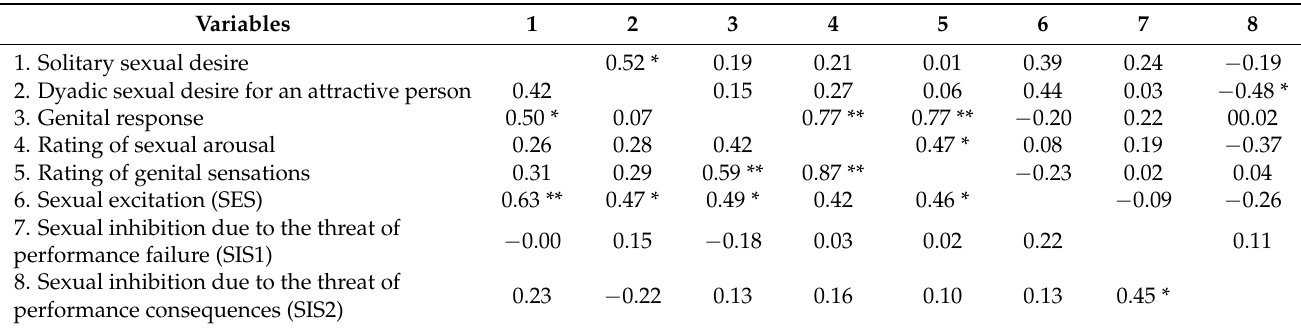
Table 6. Correlations between sexual desire (solitary and dyadic toward an attractive person) and sexual arousal.